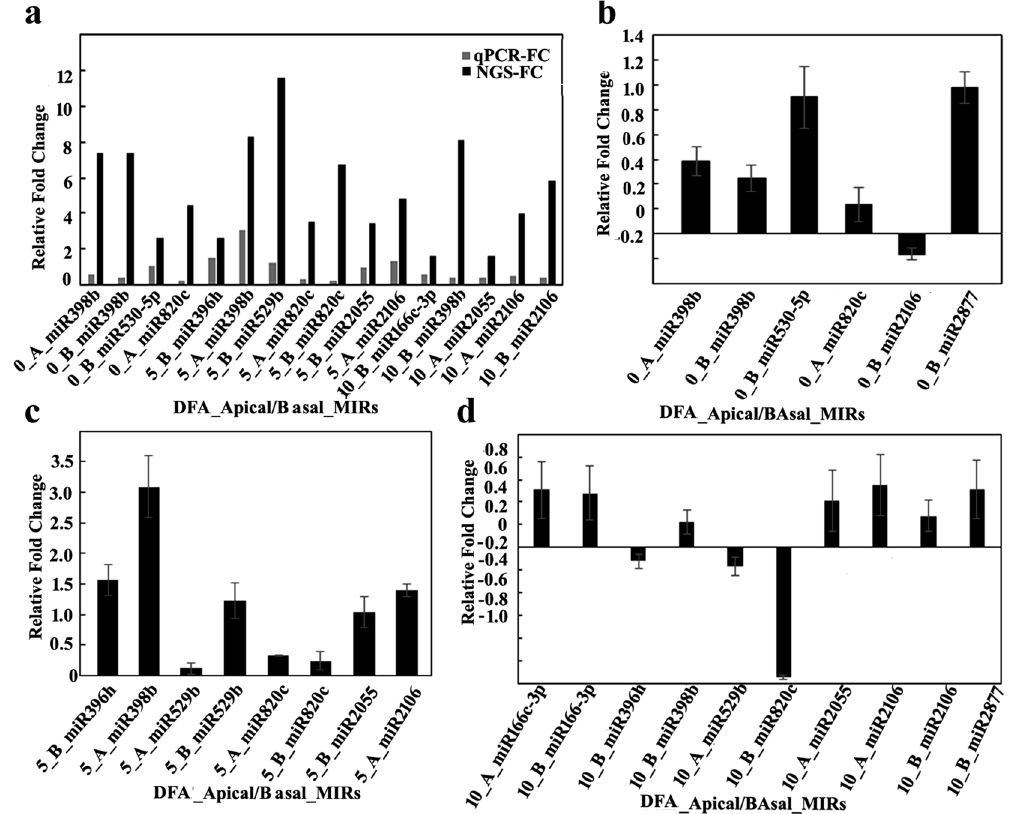
Figure 7. Relative expression of selected miRNAs (miR398b, miR530-5p, miR820c, miR396h, miR529b, miR2055, miR2106, miR166c-3p, miR2877) as per NGS data (Log2 fold-change) (black bar) and relative transcript levels in qRT-PCR (grey bar) ( a ), relative transcript level of 5 miRNAs (miR398b, miR530-5p, miR820c, miR2106, miR2877) on 0 day ( b ), 6 miRNAs (miR396h, miR398b, miR529b, miR820c, miR2055, miR2106) on day 5 ( c ) and 8 miRNAs (miR166c-3p, miR396h, miR398b, miR529b, miR820c, miR2055, miR2106, miR2877) on day 10 ( d ) post-anthesis in the apical and basal